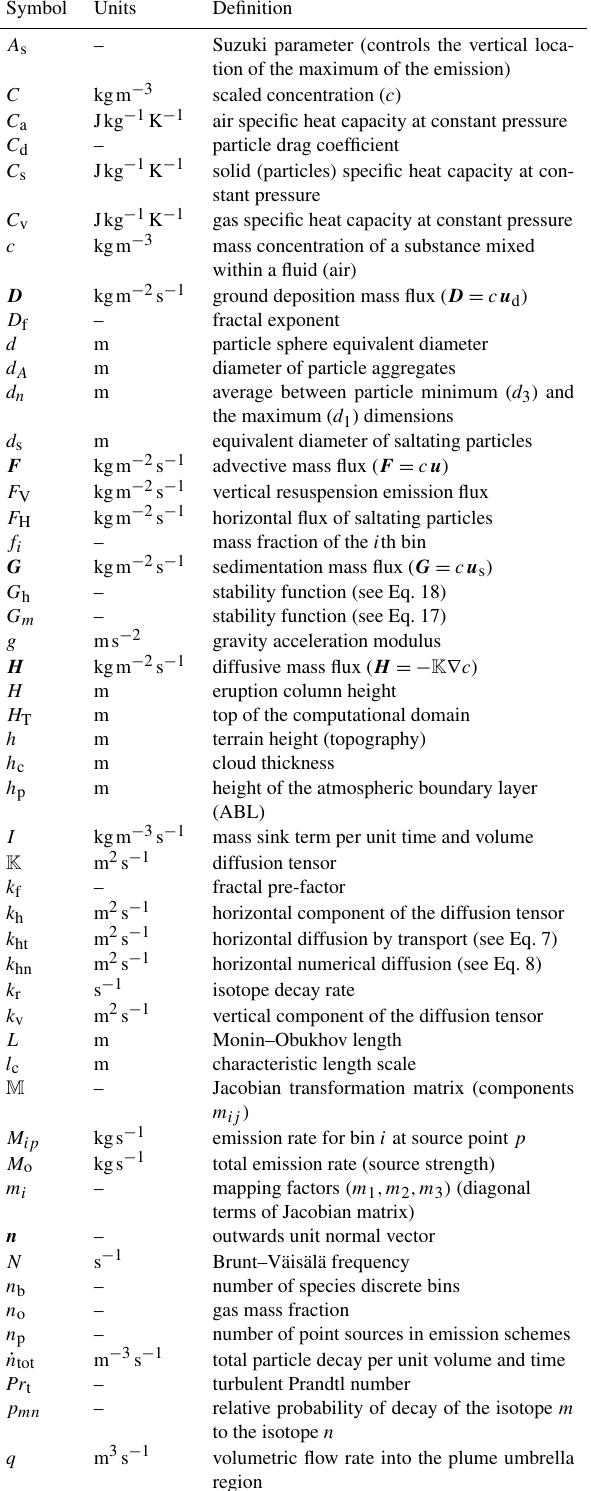
Table 1. List of Latin symbols. Bold and doubled-lined fonts indi- cate vector and tensor quantities, respectively.